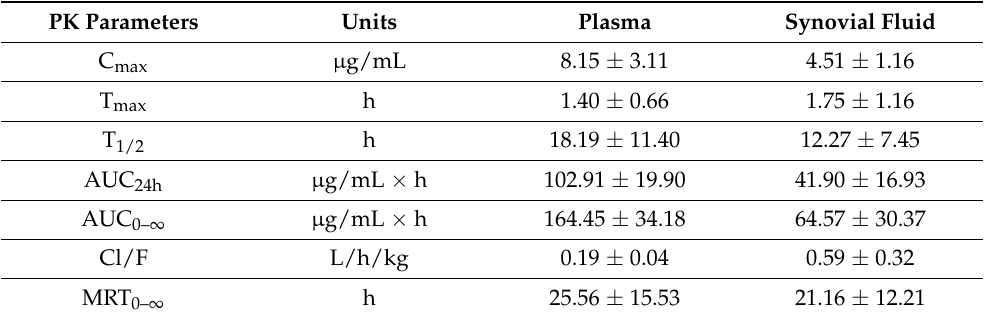
Table 1. Plasma and synovial fluid PK parameters (mean ± SD) of florfenicol (Nuflor) in pigs following intramuscular administration of 30 mg/kg bw (n = 8).